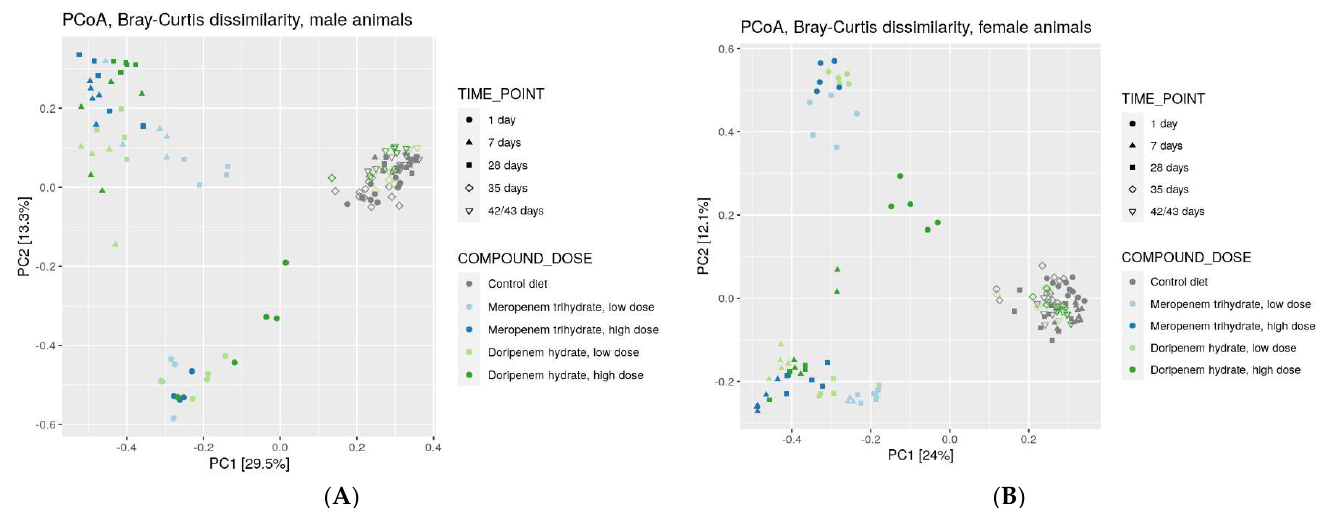
Figure 4. Principal Coordinate Analysis (PCoA) of bacterial families from controls, meropenem, and doripenem antibiotic-treated rats at different time points. Rank-based clustering with Bray-Curtis distance matrix of samples from ( A ) males and ( B ) females are presented.